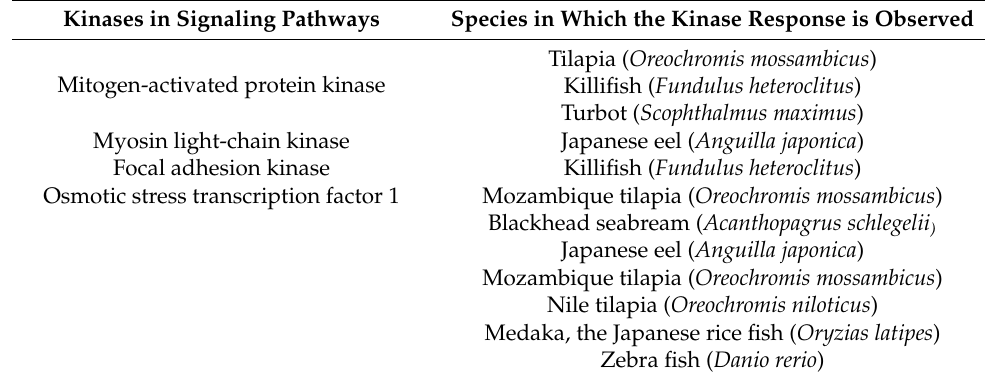
Table 2. Cellular energetic responses of different aquatic animals under salinity